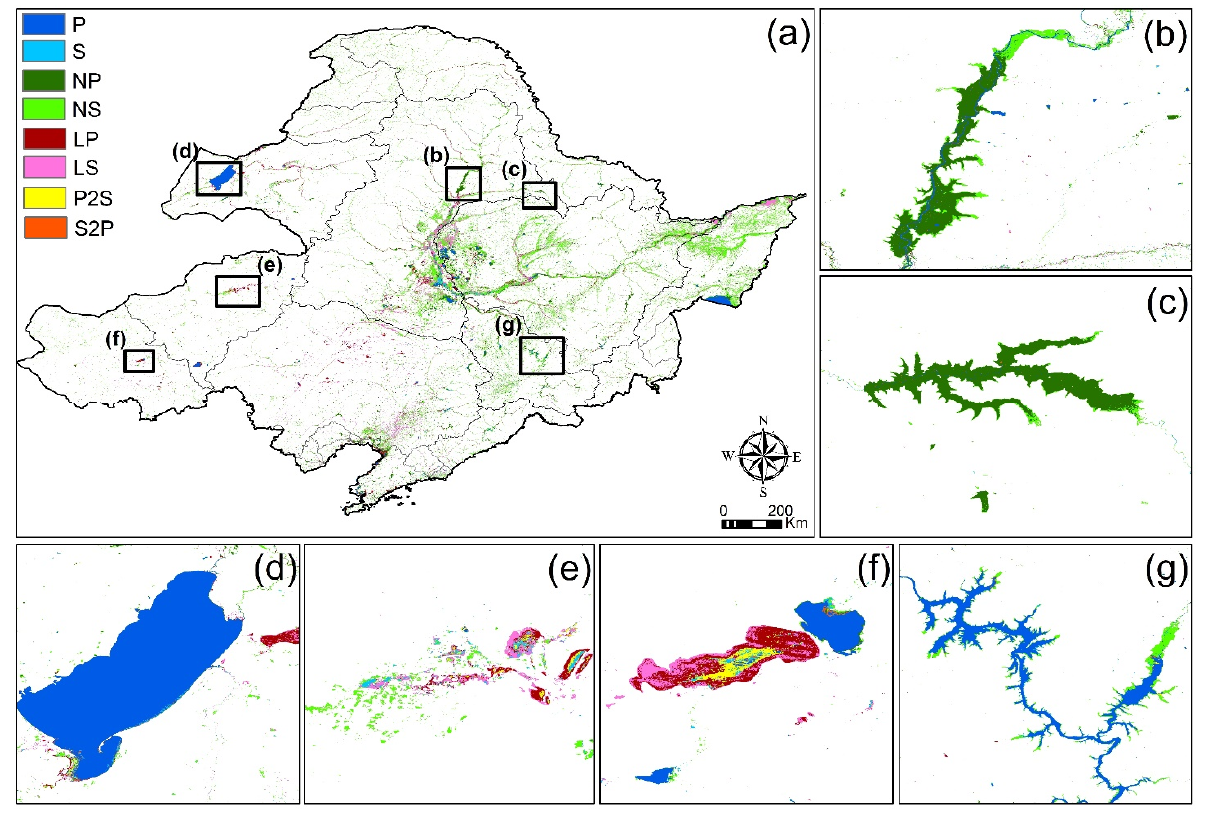
Figure 7. ( a ) Spatial pattern of surface water conversion in Northeast China for 1988–2020, and the water body conversion of ( b ) Nierji Reservoir, ( c ) Shankou Reservoir, ( d ) Hulun Lake, ( e ) Ulangai Lake, ( f ) Chagannuoer, and ( g ) Fengman Reservoir, respectively.